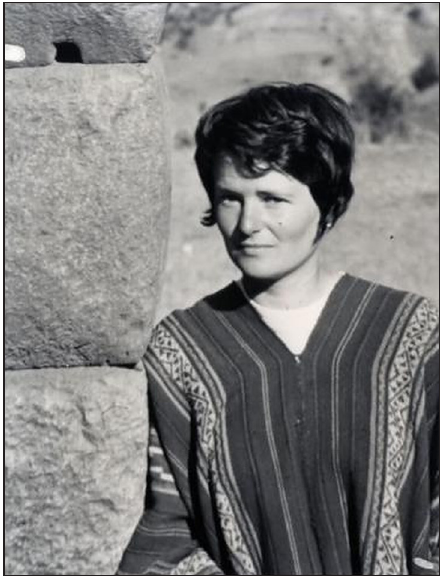
Figure 5: Ann Kendall (Photo: Senate House